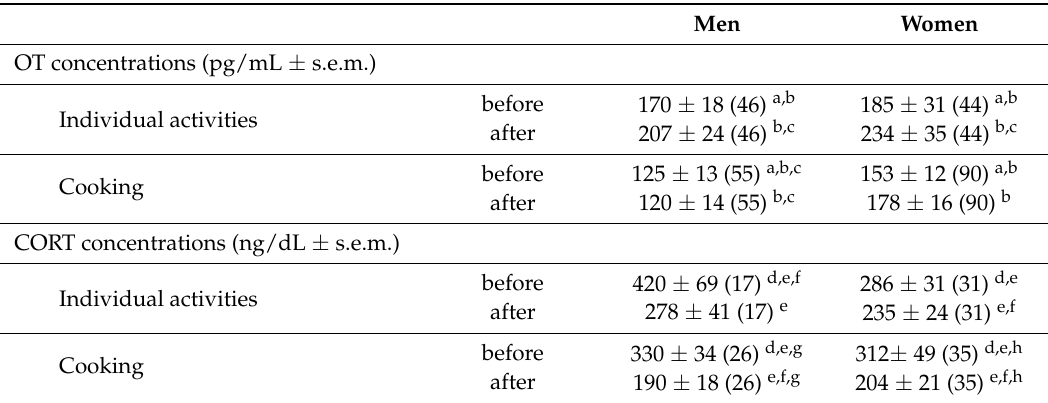
Table 2. Baseline concentrations of oxytocin and